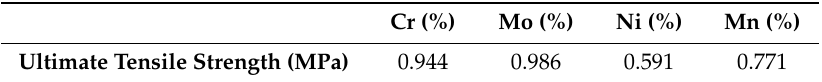
Table 16. Pearson correlation coe ffi cient between phase stabilizers and ultimate tensile strength of duplex stainless steel.